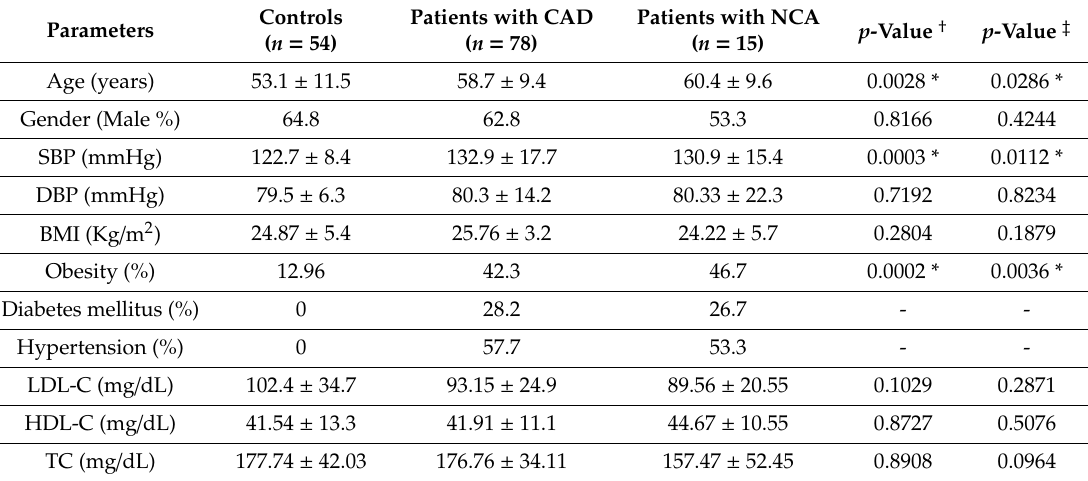
Table 1. Baseline clinical characteristics of all the study